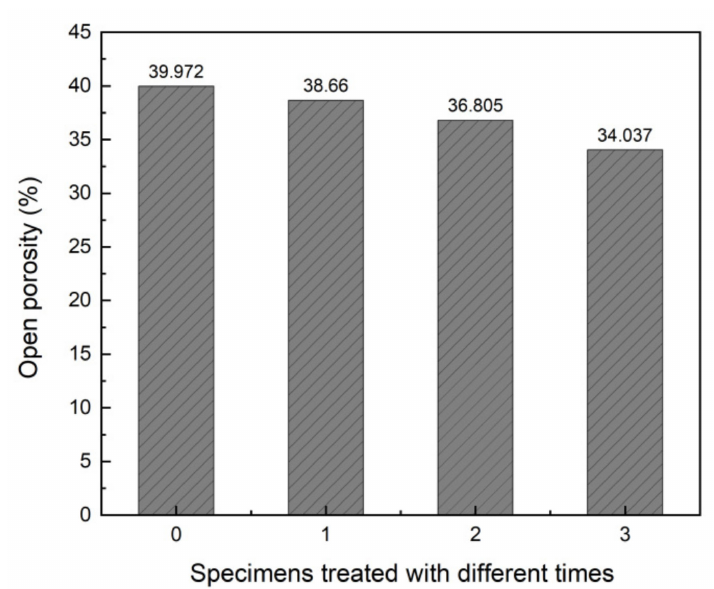
Figure 12. Open porosity of the specimens before and after